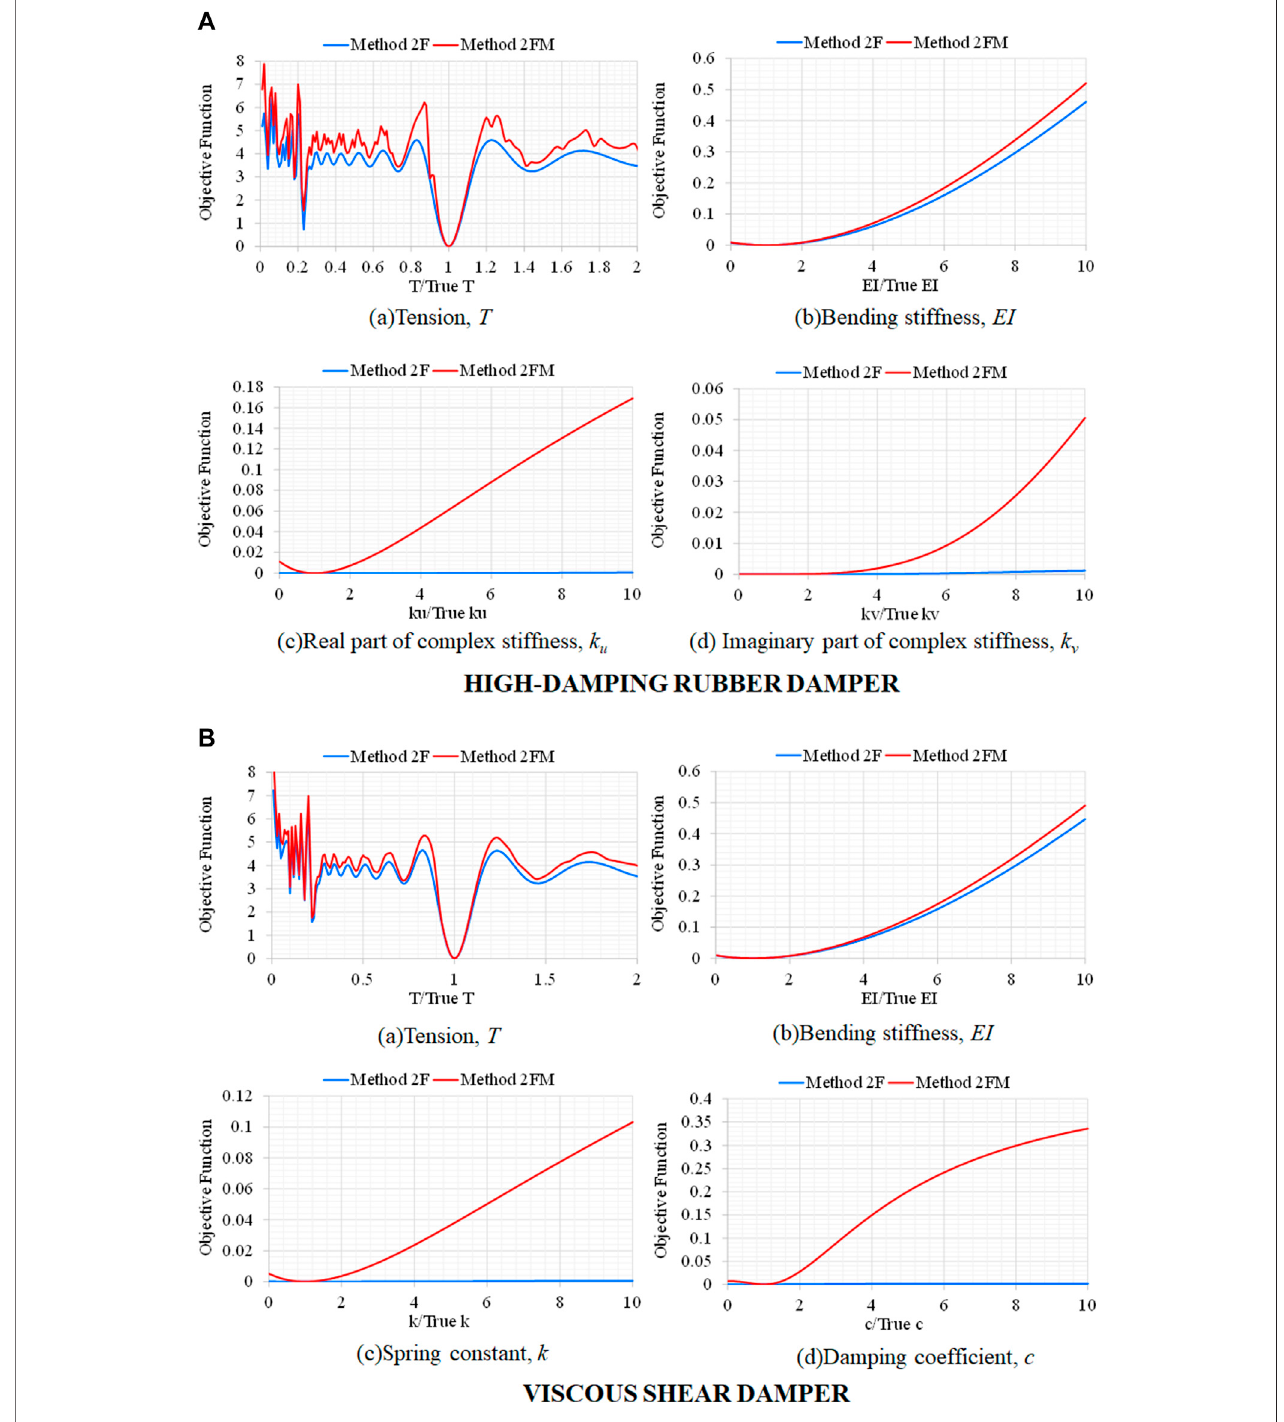
FIGURE 5 | Sensitivity analysis results for model No. 33 without measurement noise: (A) high-damping rubber damper; (B) viscous shear damper.